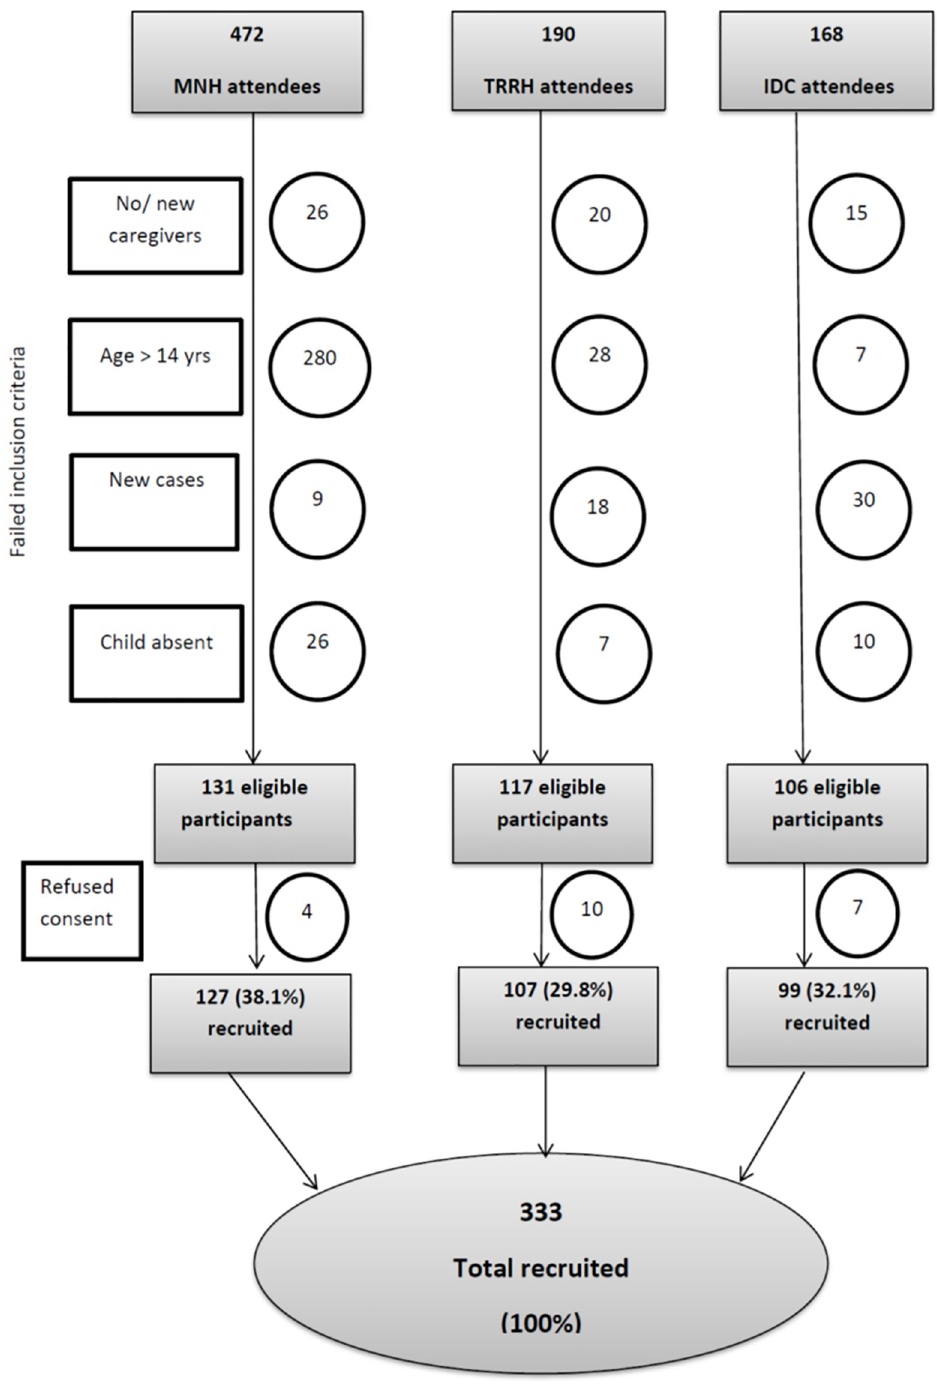
Fig 1. Flow diagram showing recruitment of